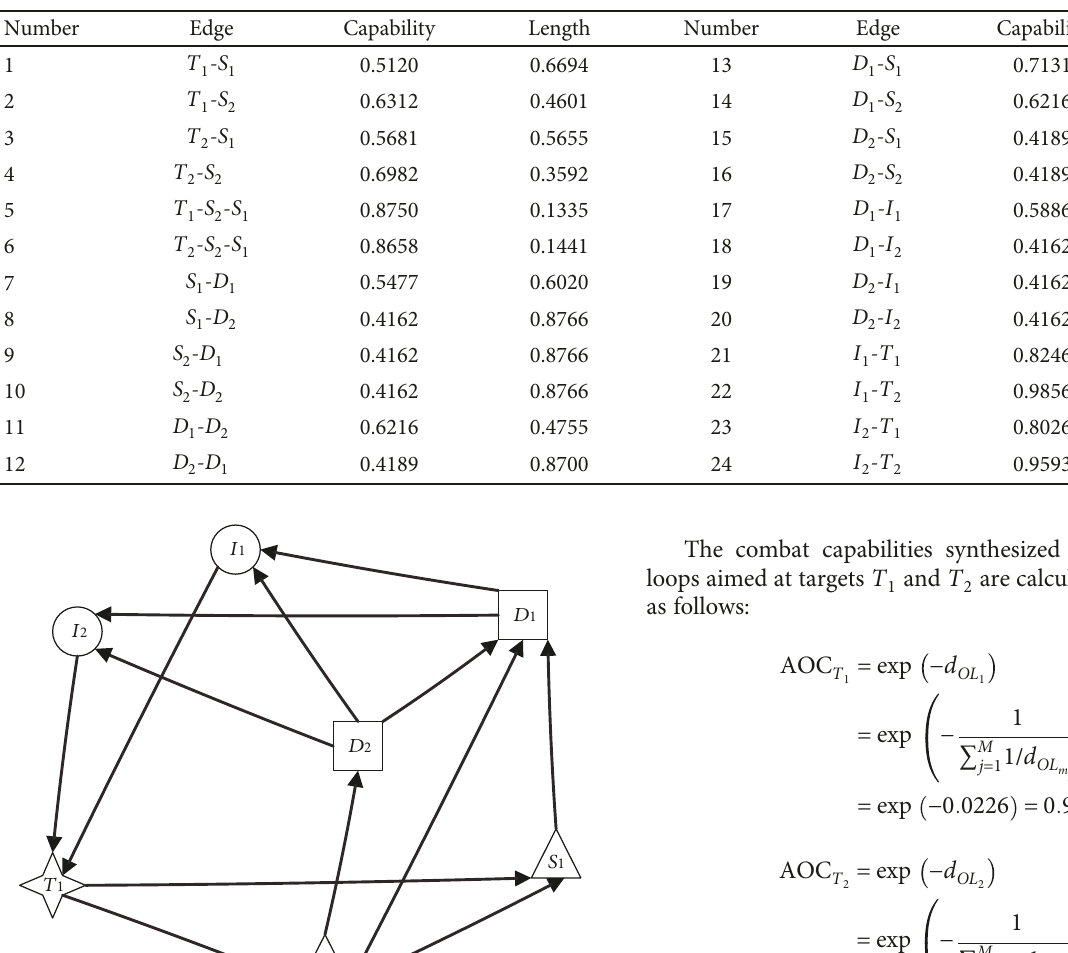
Table 5: Edge capability and length.